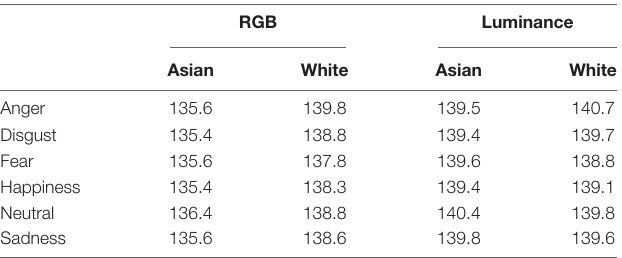
TABLE 1 | Stimuli color matching across two